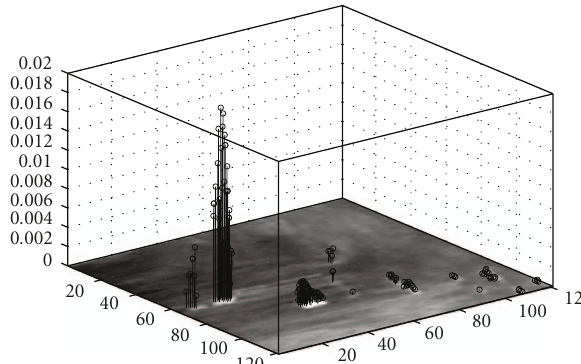
Figure 4: Particle Filtering-based approximation of the posterior probability p ( x k | z 1: k ).